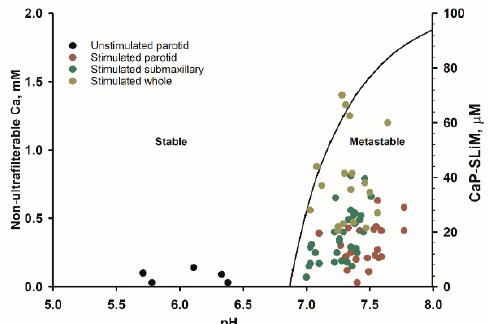
Figure 12. Superposition of salt partition data for stimulated and unstimulated saliva [122,227] on the stability diagram of saliva calculated by [13]. The composition of unstimulated saliva falls is in the stable part of the diagram but the rise in pH on stimulation increases the pH to where the saliva may be either stable or metastable, depending on the concentration of CaP-SLiMs.